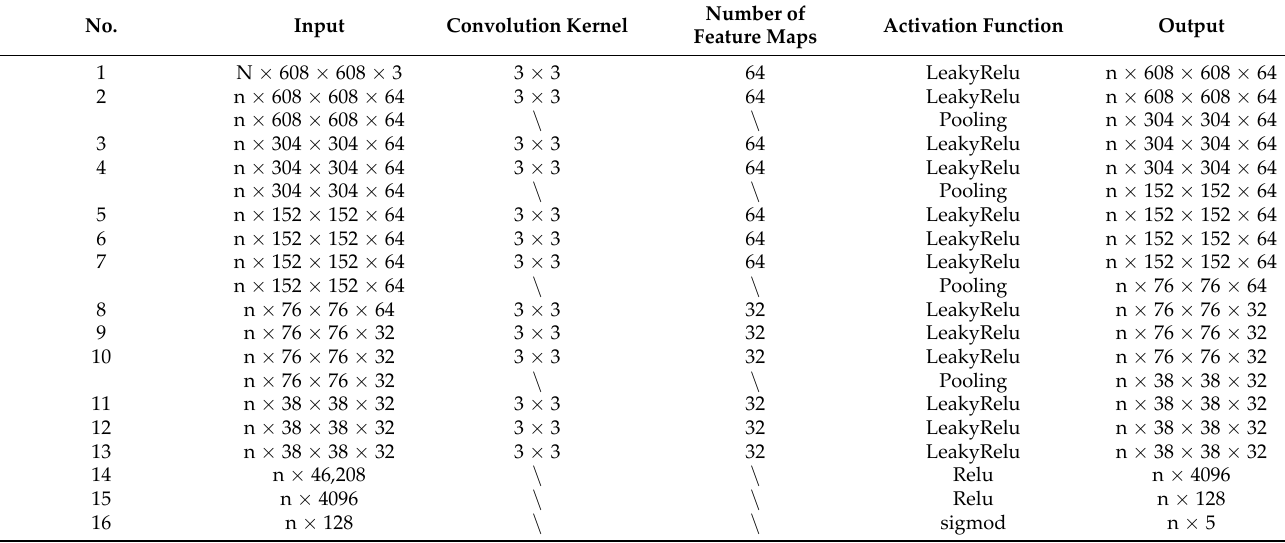
Table 4. Conventional layers of the detection